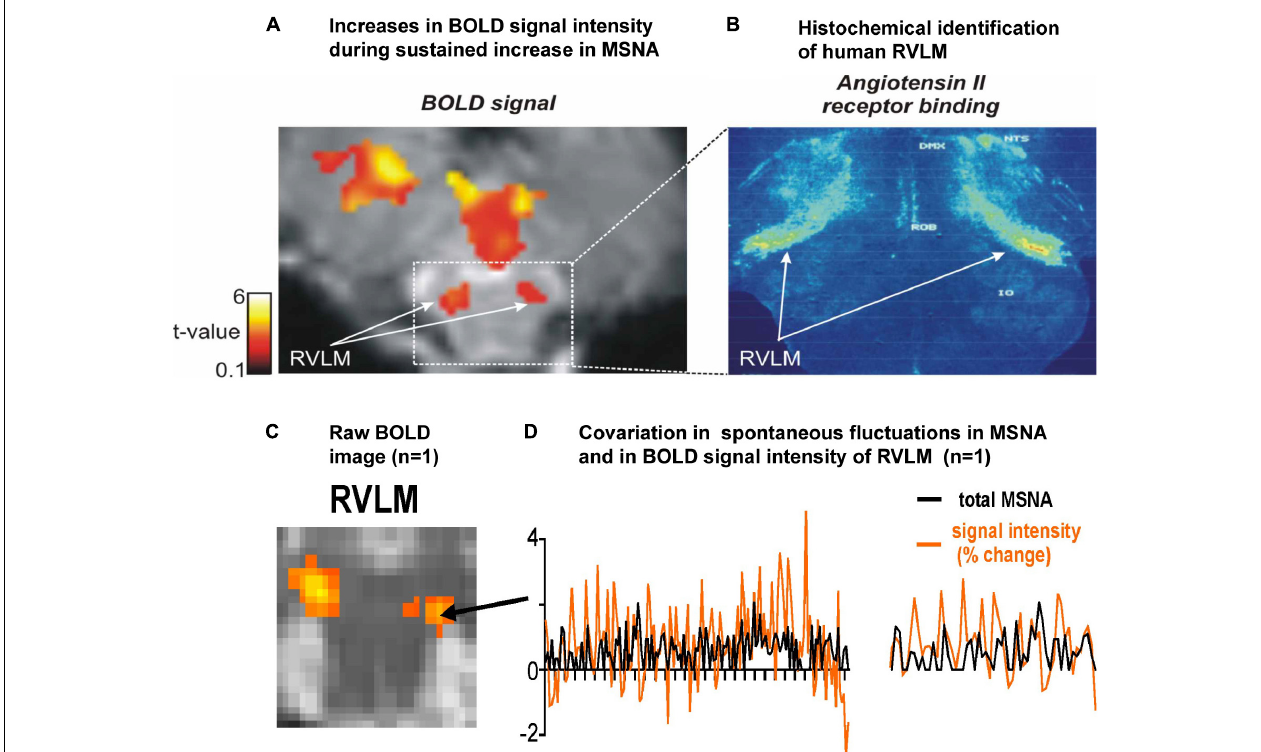
FIGURE 1 | (A) Axial section of the rostral medulla showing bilateral increases in BOLD signal intensity in the dorsolateral medulla – the region of the human rostral ventrolateral medulla (RVLM) – during sustained increases in MSNA during a set of three maximal inspiratory breath-holds in 15 participants. (B) Histochemical identification of the human RVLM based on the high density of Angiotensin II receptor binding (data reproduced with permission from Allen et al., 1998). (C) Bilateral increases in MSNA-coupled BOLD signal intensity in the region of the RVLM. (D) Covariation in total MSNA, shown as the total amplitude of MSNA measured in each 1 s epoch, and BOLD signal intensity in the corresponding 1 s epochs, measured over 30 s in the region indicated in panel (C) for the same participant; an expanded section is shown on the right. Reproduced, with permission, from Macefield and Henderson (2019).